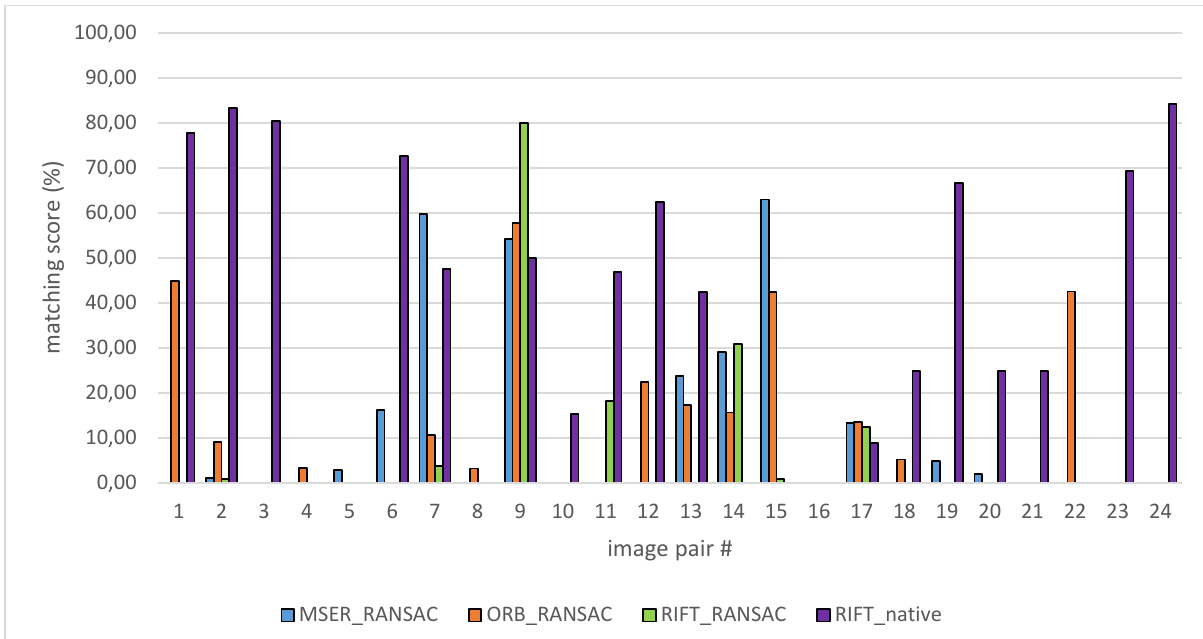
Figure 2. Matching scores of every image pair for the four best performing algorithms MSER_RANSAC, ORB_RANSAC, RIFT_RANSAC, and RIFT_native